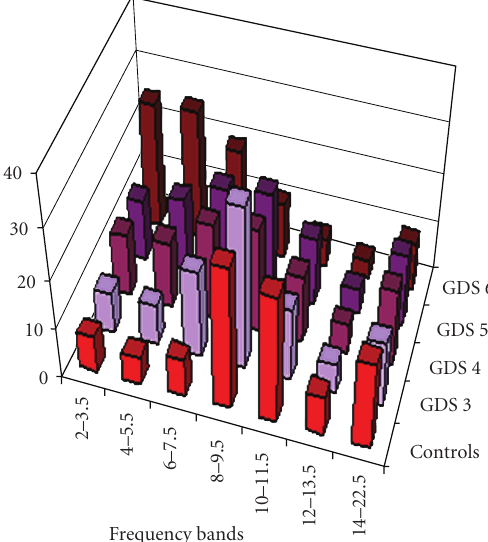
Figure 2: Histogram showing the relationship between 7 EEG fre- quency bands (2–3.5; 4–5.5; 6–7.5; 8–9.5; 10–11.5; 12–13.5;14– 22.5Hz) and disease’s severity (normal controls and 4 clinical class- es of severity; GDS 3 to